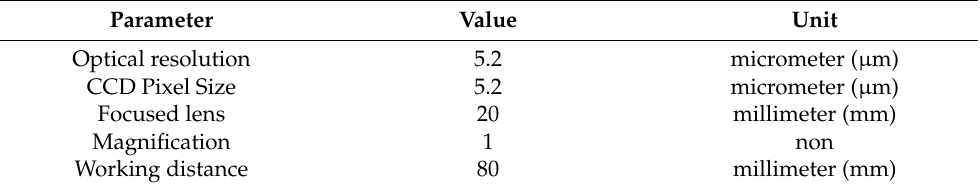
Table 1. The parameter of working distance in the optical evaluation.